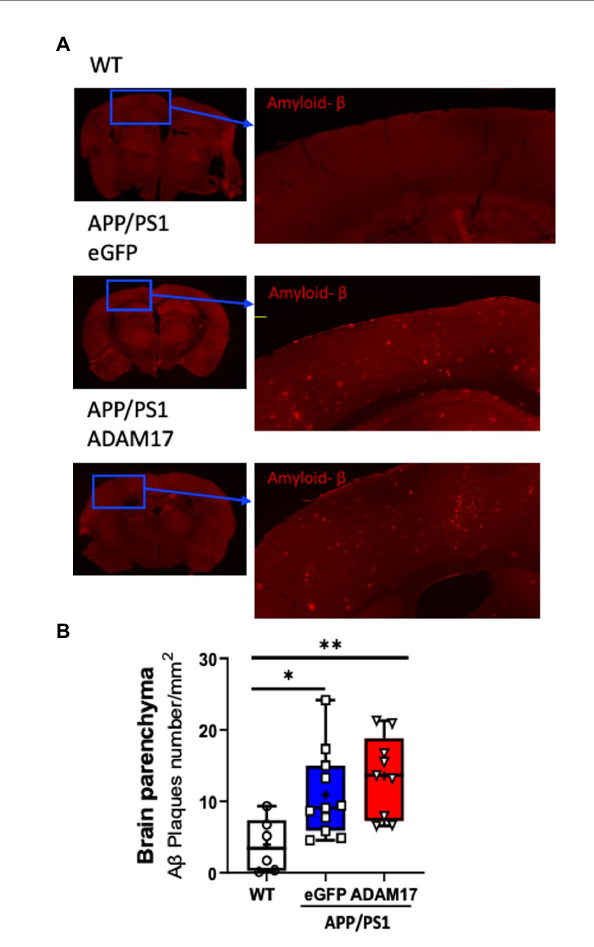
FIGURE 5 Amyloid- β plaque density was unchanged after ADAM17 re-expression in APP/PS1 mice. (A,B) Amyloid-beta (A β ) plaques were identified via immunofluorescent staining and quantified. The number of A β plaques was significantly increased in the APP/PS1 mice and was unchanged with the ADAM17 injection. n =6 − 11. * p < 0.05 ** p < 0.01. Two way ANOVA was used.